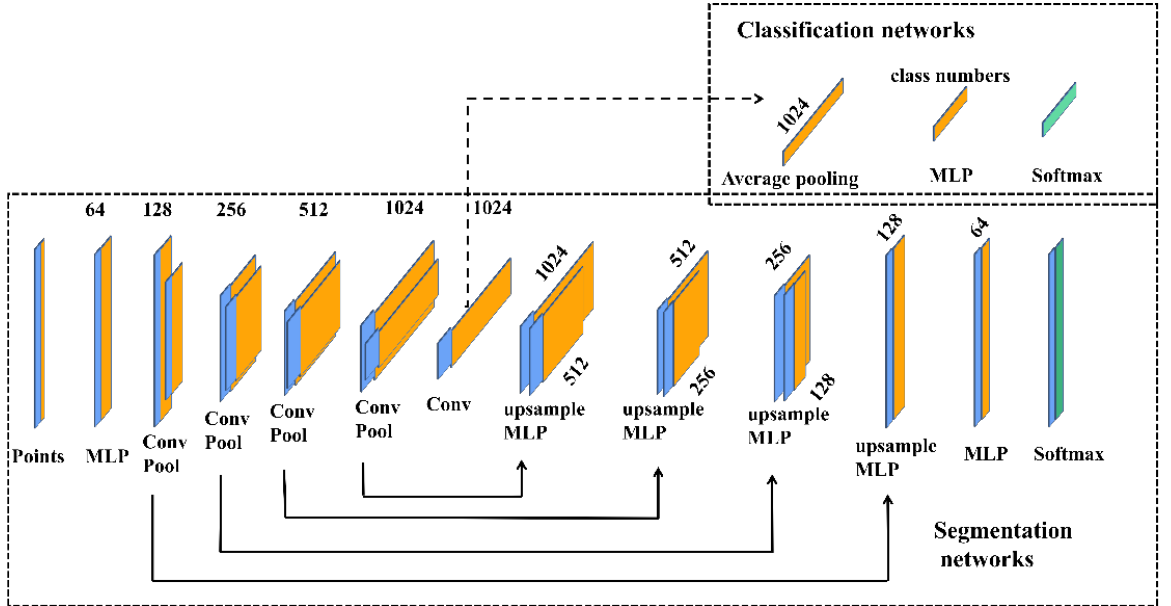
Figure 8. The overall architecture of the network: The backbone uses the encoder – decoder archi- tecture and the skip connection. The upper branch shows the classification networks. The bottom branch shows the semantic segmentation networks.